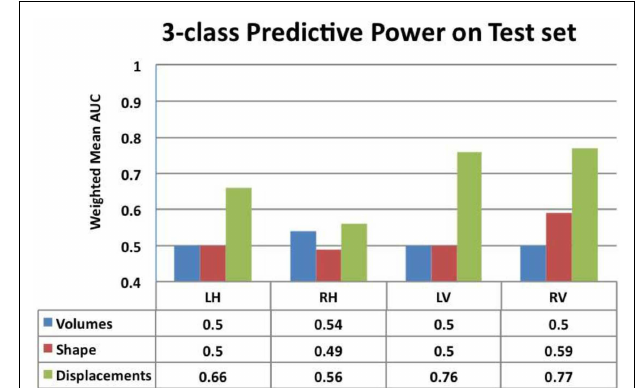
FIGURE 6 |The procedure used to evaluate the predictive value of different features is illustrated here for the two types of experiments . We first split the cohort into the training set (75% of the cohort, or N -1 subjects in case of LOOCV) and use the remaining for the test set, preserving the class proportions. Although the full cohort is matched in age and gender, this might not be preserved in the training and test splits.Then, we reduce the dimensionality of the features to the top five features ranked by their information gain, which would then be passed to the SVM classifier (using a radial basis function kernel).We perform model selection for SVM on the training set only in order to obtain the most discriminative model for the particular feature. And the optimal model is used to classify the subjects